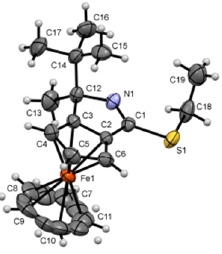
Figure 4. Molecular structure of 12a according to XRD data in the thermal ellipsoids of the 35% probability level (only the ( S p )-enantiomer is shown).